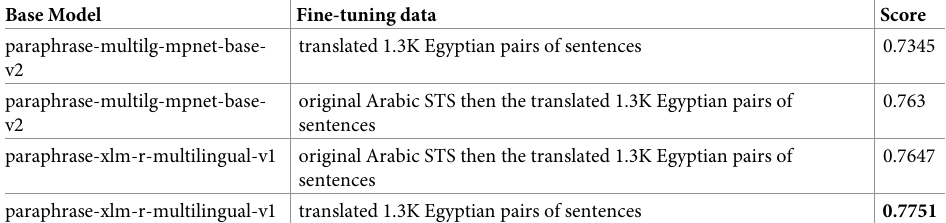
Table 5. Accuracy of main Egyptian models tested based on Spearman rank correlation between the cosine simi- larity of sentence representations and the reference labels of the testing dataset in [8] after translation to Egyptian Arabic.